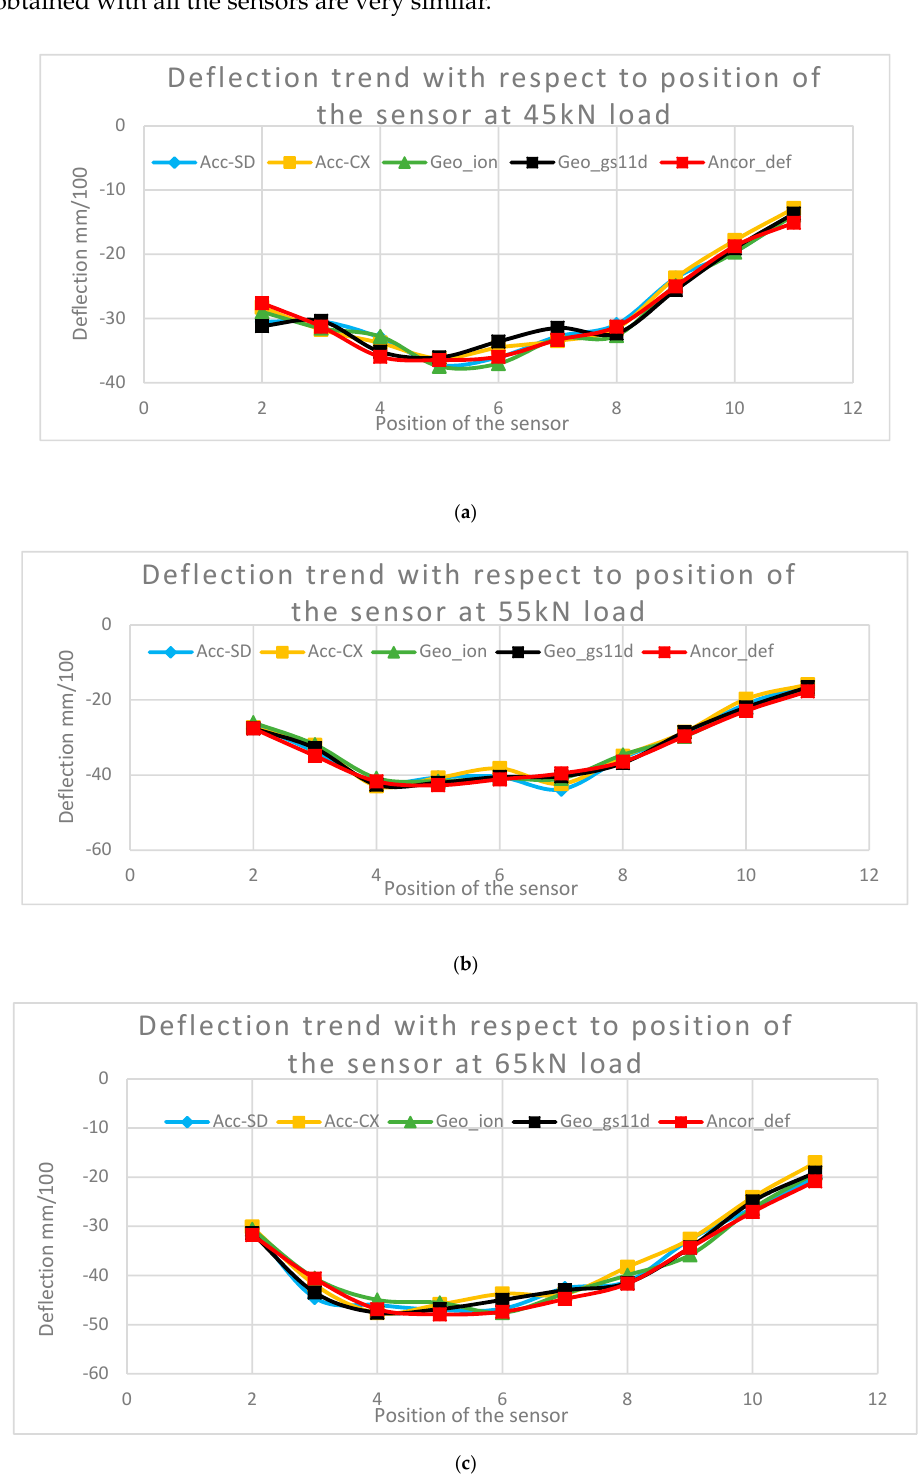
Figure 19. ( a ): Evolution of deflections with the position of the wheels, for 45 kN load and 16 m / s speed. ( b ): Evolution of deflections with the position of the wheels, for 55 kN load and 16 m / s speed. ( c ): Evolution of deflections with the position of the wheels, for 65 kN load and 16 m / s